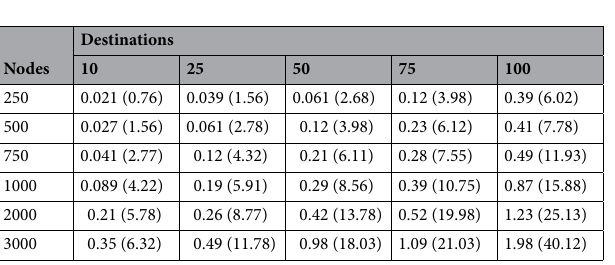
Table 4. Rerouting time of REMTC and ST